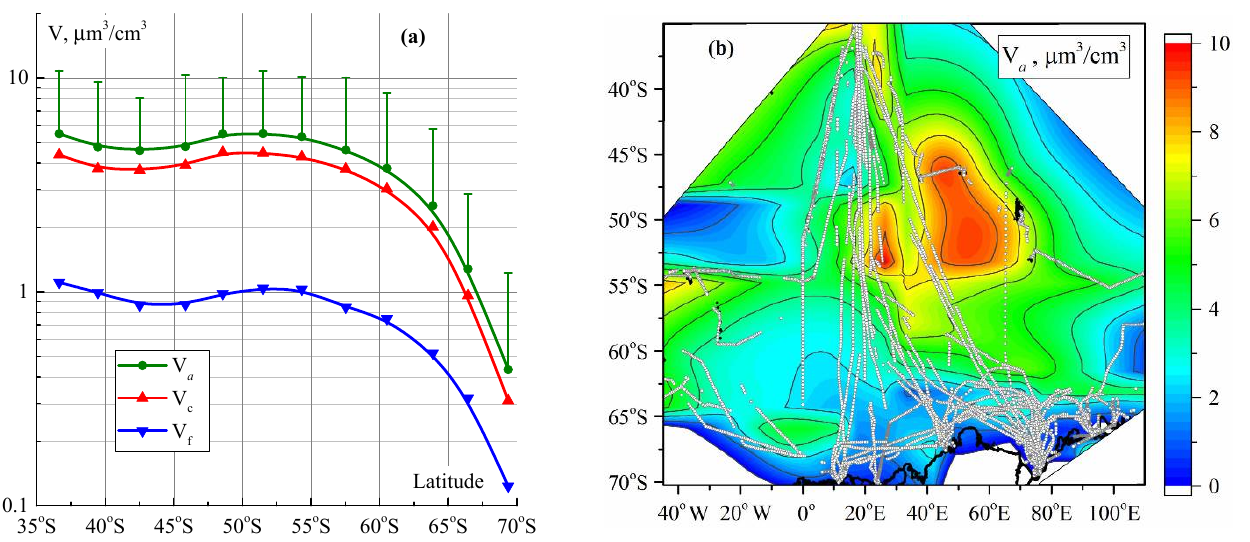
Figure 5. Average spatial distribution of volumes of aerosol particles: ( а ) latitude behavior of V а , V f , and V c ; and ( b ) latitude–longitude distribution of V а based on the interpolation of ship-based data.